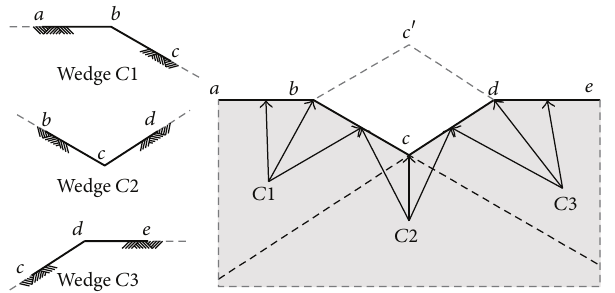
Figure 4: Representation of the V-shaped canyon through the superposition of finite wedges. Each wedge contributes with a discretesourceofdiffractionandtwocontinuoussourcesofreflected rays represented by the free boundaries. Each point singularity introduces a boundary of discontinuity in the optical field. Full continuity is restored by the diffracted waves emanated by the tips.